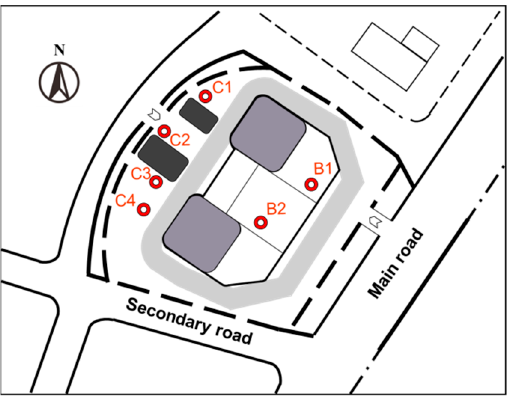
Figure 6. The layout of dust suppression areas at the construction site. C1 is the monitoring point. C2, C3 and C4 are monitoring points in the dust suppression area. B1 and B2 are the monitoring points in the control area. Table 6. Concentration of suspended particles at the dust suppression site ( μ g/m 3 ).